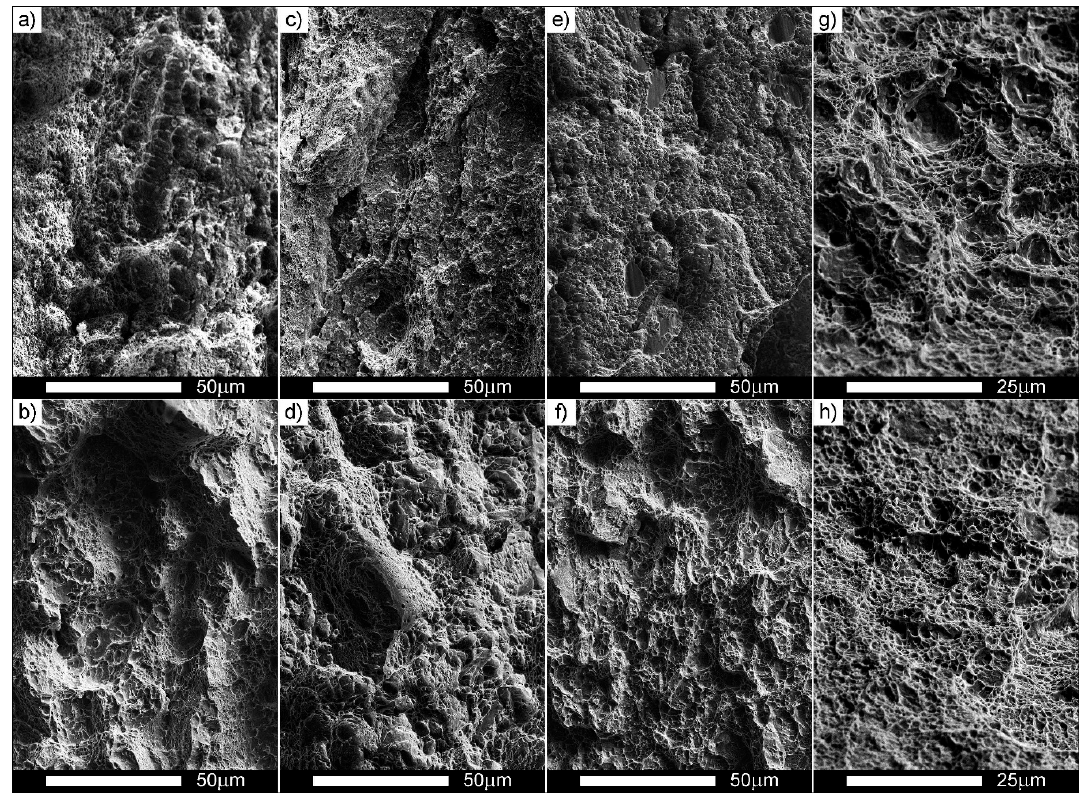
Figure 17. Various fracture zones of the Hardox 600 joints shown in Figure 16c,d: ( a ) AW-KCV-3 below the notch (frame C1); ( b ) HT-KCV-1 below the notch (frame D1); ( c ) AW-KCV-3 in the central zone (frame C2); ( d ) HT-KCV-1 in the central zone (frame D2); ( e ) AW-KCV-3 in the final fracture zone (frame C3); ( f ) HT-KCV-1 in the final fracture zone (frame D3); ( g ) AW-KCV-3 in the side zone (frame C4); and ( h ) HT-KCV-1 in the side zone (frame D4). SEM, unetched.